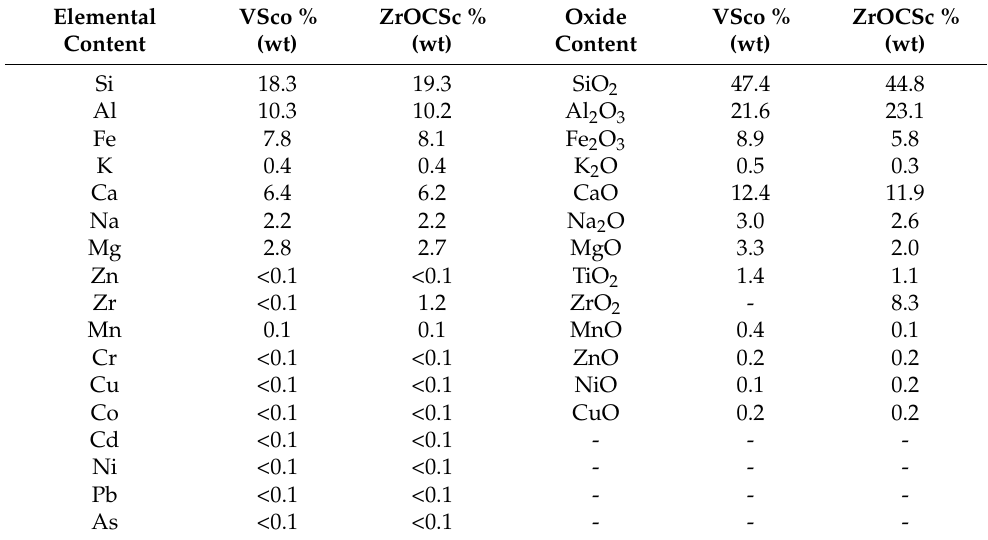
Table 1. Elemental and oxide compositions of virgin scoria (VSco) and zirconium oxide-coated sco- ria (ZrOCSc).